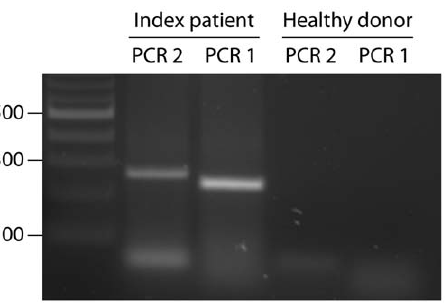
Figure 3. PCR with primers (Table 1) overlapping exons 10 and 13 gave amplimers only when applied to patient’s cDNA, but not when applied to cDNA from a healthy donor. The correct sequence of the amplimers was confirmed. Ordinate: length in bp.